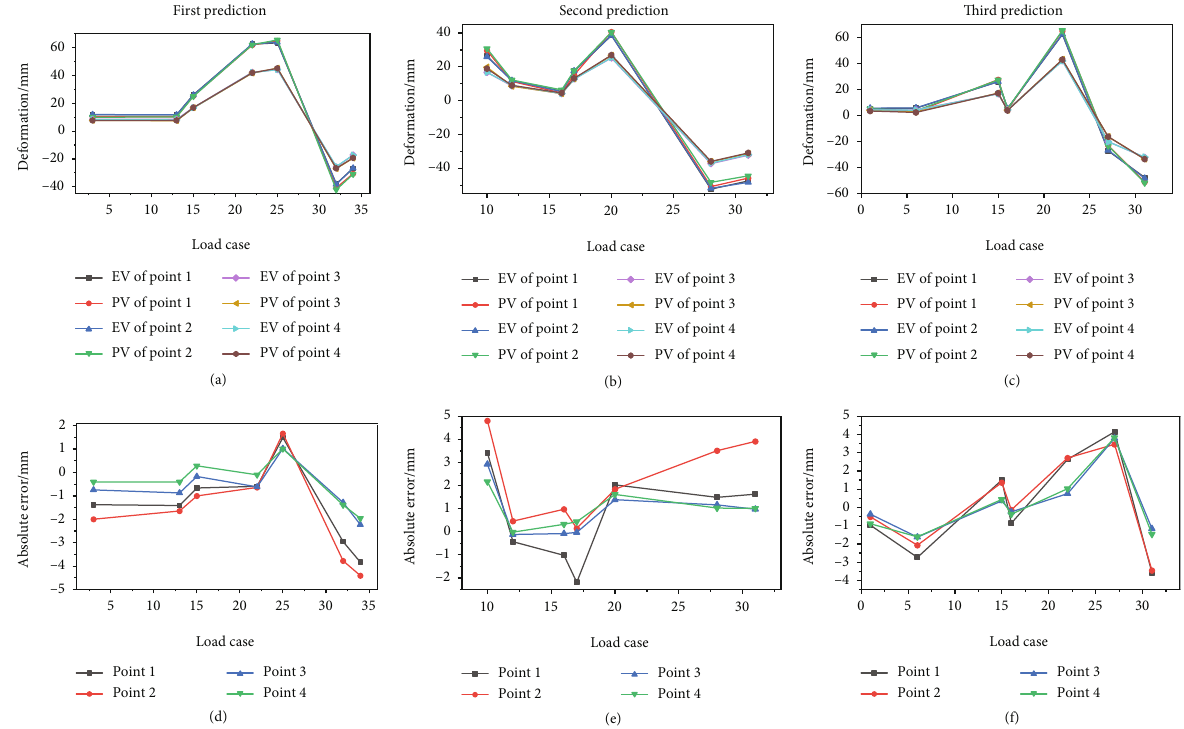
Figure 11: Predicted and exact values of displacement of RR